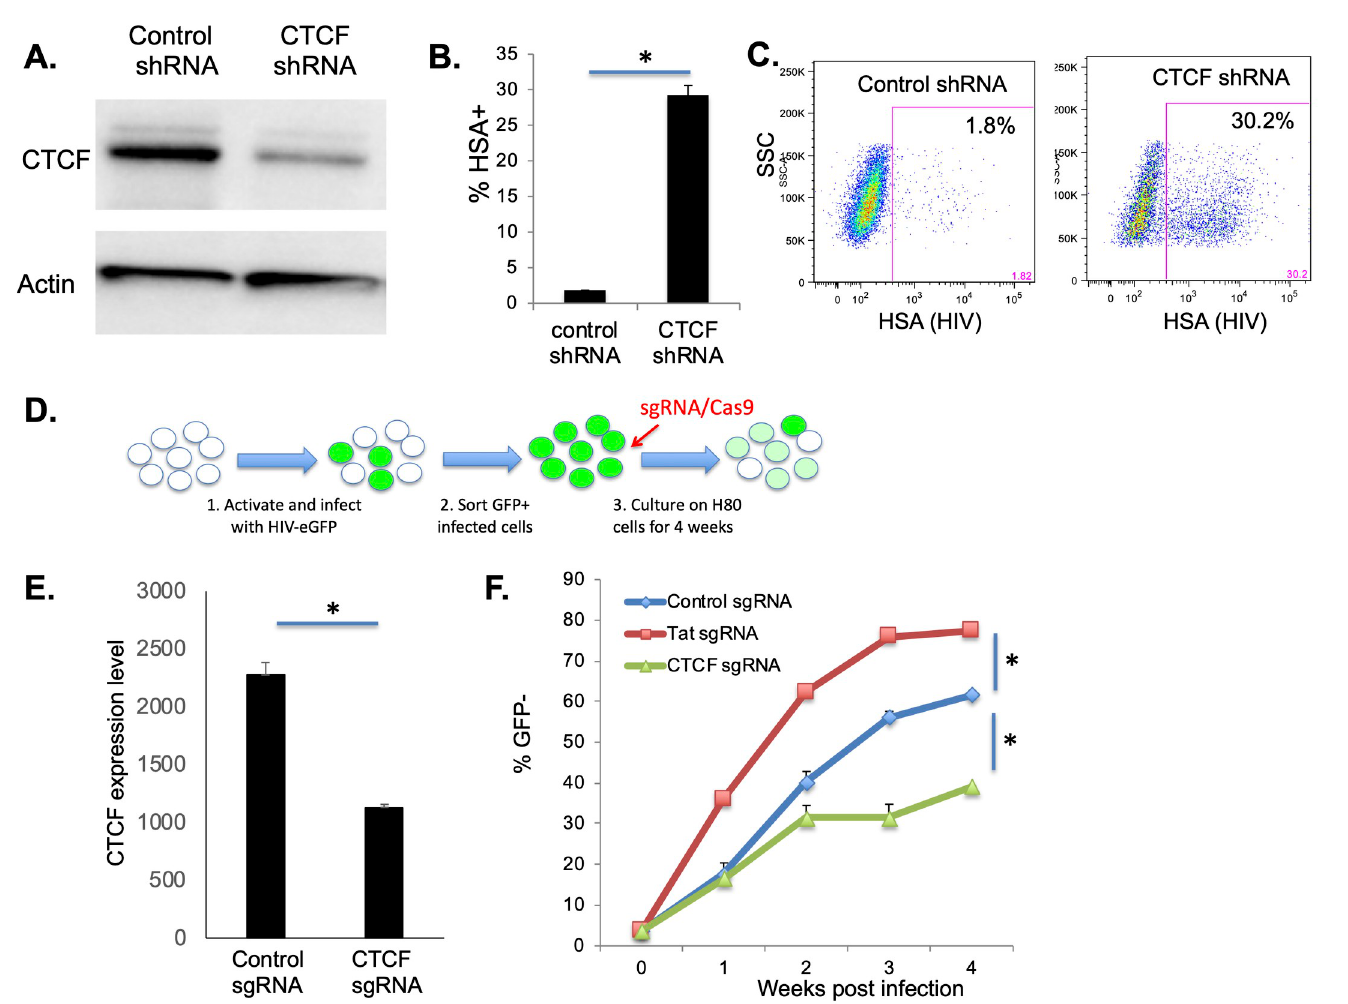
Fig 7. CTCF depletion in latently infected CD4 T cells inhibits HIV latency. N6 cells were transduced with lentiviruses that express mCherry and an shRNA targeting CTCF or a control scrambled shRNA. A. Transduced N6 cells were analyzed by western blot to examine CTCF expression as well as a loading control ( β -Actin). B. Transduced N6 cells were analyzed at 2 weeks post infection by flow cytometry, and the percentage GFP+ cells within the mCherry+ gate determined. Data represent the average of two technical replicates from one of two representative experiments. C . A representative FACS plot of HSA expression in shRNA transduced N6 cells. D . Primary CD4 T cells at 2 days post activation were infected with HIV-GFP, then nucleofected with Cas9 complexed with a control sgRNA, a Tat sgRNA or a CTCF sgRNA. E. At one week post infection, the impact on CTCF mRNA levels, relative to beta-actin was quantified by Taqman qPCR. CTCF expression is displayed in arbitrary units and represents the average of four replicates. F . The infected/nucleofected cells were analyzed for GFP expression over four weeks of infection and the percent of latently infected (GFP-) cells was determined. Each datapoint is the average of two independent nucleofection reactions. Asterisks represent significant differences (P < 0.05, Student’s T